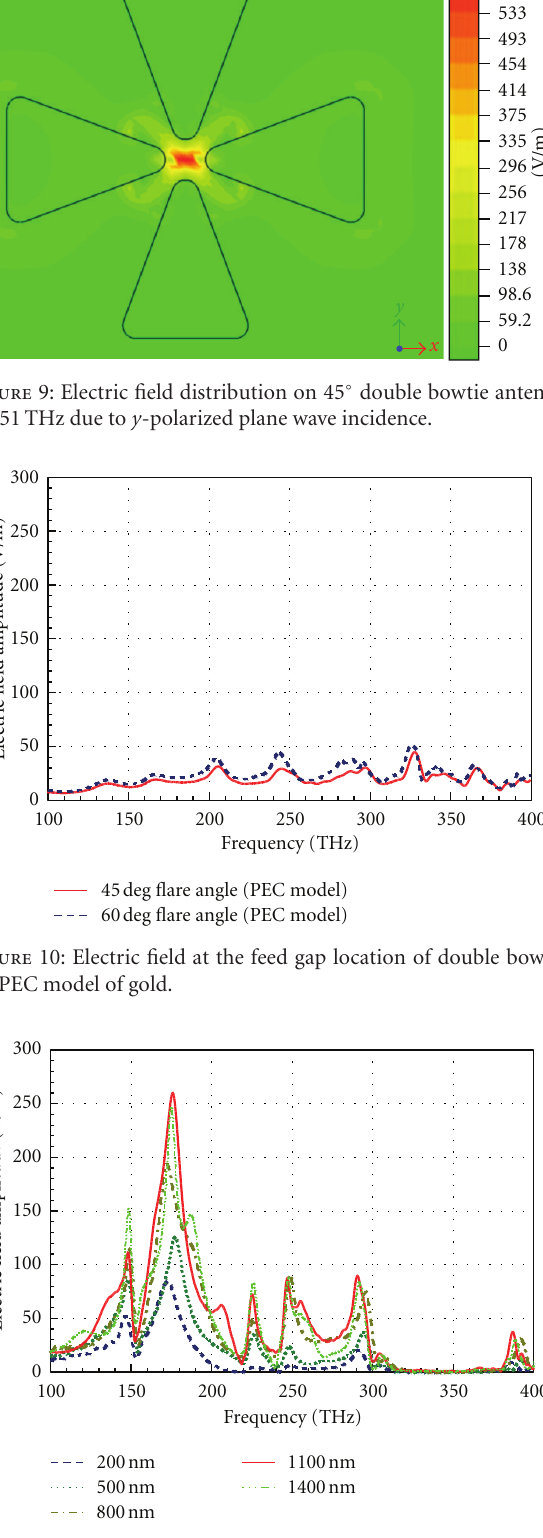
Figure 11: Electric field variation at the feed location of 90 ◦ single bowtie for di ff erent glass thicknesses varying from 1400 nm to 200